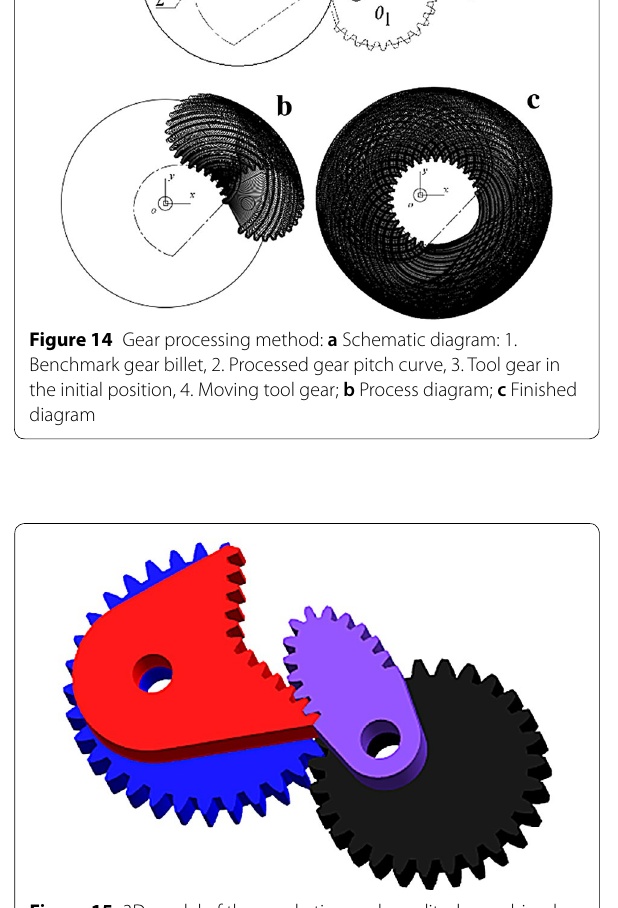
Figure 15 3D model of the quadratic equal-amplitude combined